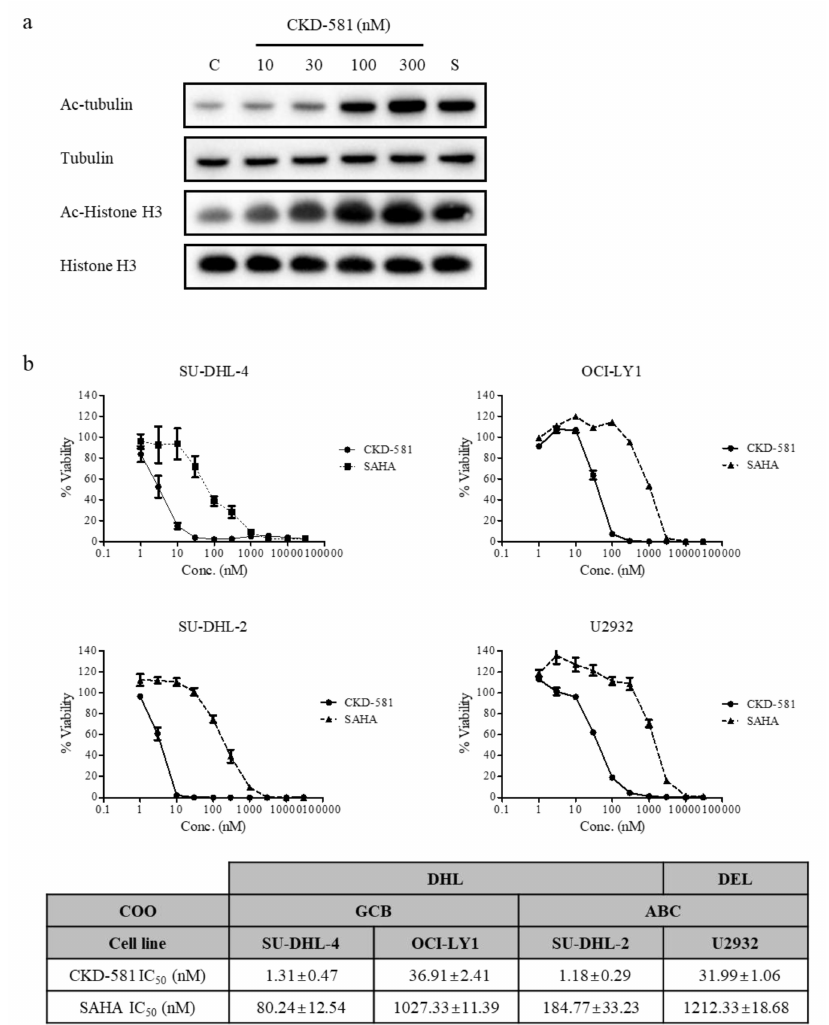
Figure 1. CKD-581 is a potent HDAC inhibitor. ( a ) Acetylation of tubulin or histone H3. SU-DHL-2 cells were treated with vehicle control (C), CKD-581 (10–300 nM), or 300 nM SAHA (S) for 6 h, and total cell lysates were obtained. Acetylation of tubulin or histone H3 was determined by immunoblotting. ( b ) Comparison of inhibitory e ff ects of CKD-581 and SAHA on cell viability of four DLBCL cell lines. SU-DHL-4, OCI-LY1, SU-DHL-2, and U2932 cells were incubated with CKD-581 and SAHA for 72 h, and cell viability was assessed by a CellTiter Bright-Glo assay. Data represent mean ± SEM ( n =